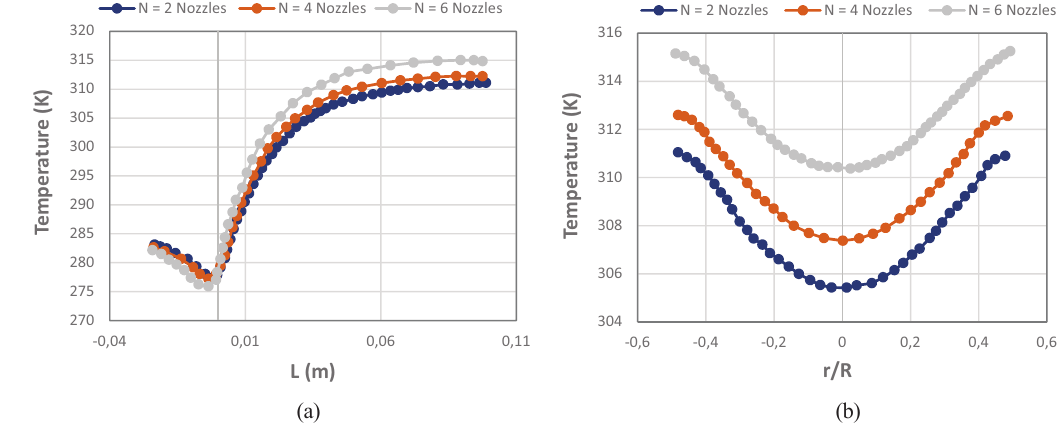
Figure 12. The diagram of (a) temperature distribution along the axial center line and (b) radial direction in the middle of the vortex